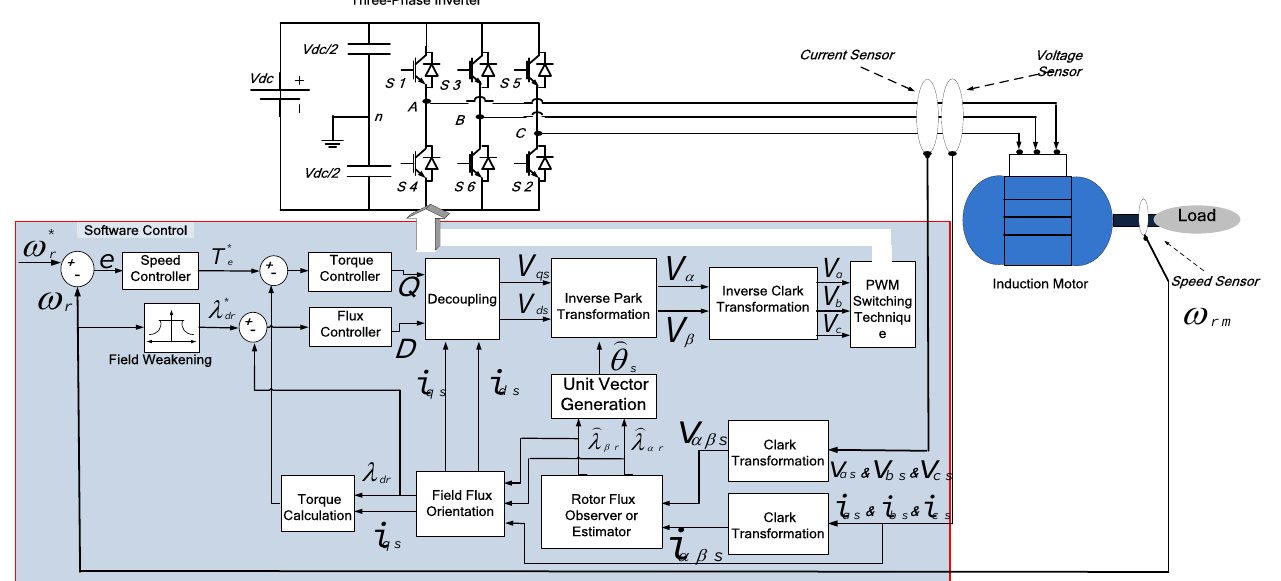
Figure 1. Block diagram of DFOC for IM drive.